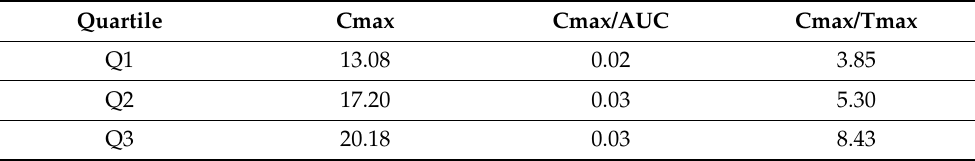
Table A1. Quartiles of the distribution of the Cmax, Cmax/AUC, and Cmax/Tmax estimates from the original bioequivalence dataset of donepezil.